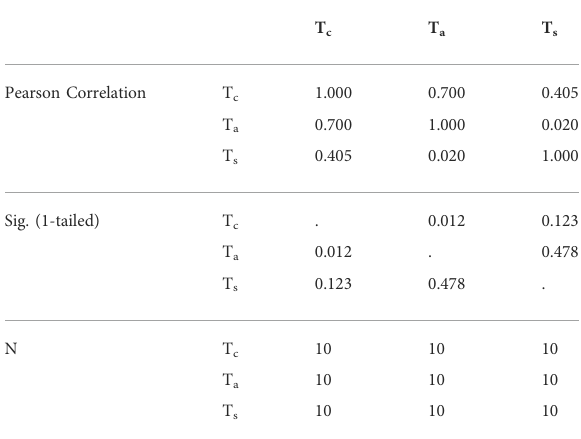
TABLE 3 Correlations between car cabin temperature, air temperature, and car-skin temperature.